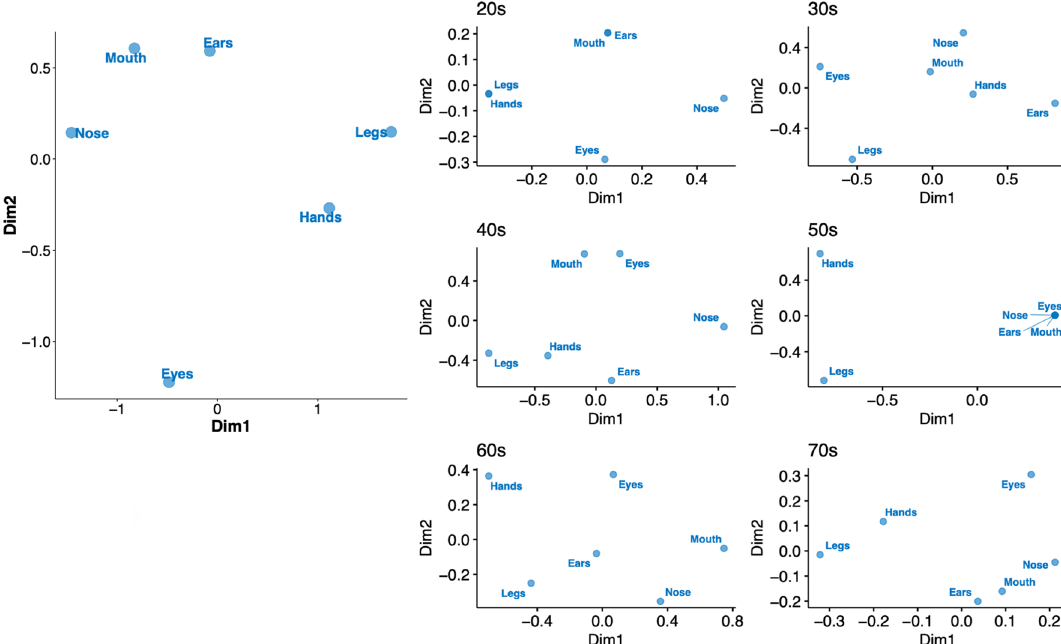
Figure 4. Internal configurations of the body parts with multidimensional scaling analyses for discomfort. The left-side panel shows the whole participants’ data and right-side panels show each age group data. Plots were generated using R software version 4.0.1 (R Core Team (2020). R: A language and environment for statistical computing. R Foundation for Statistical Computing, Vienna, Austria. http:// www.R- proje ct.